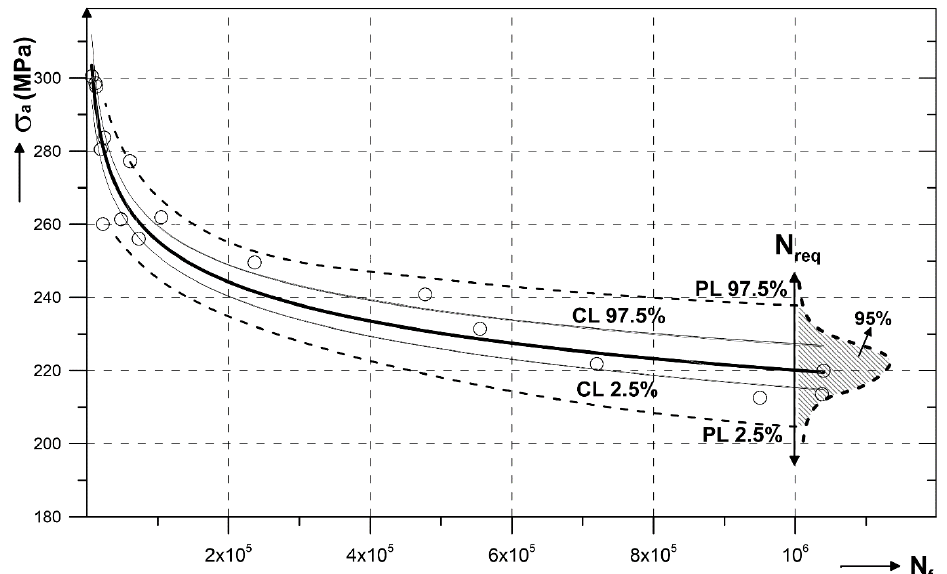
Figure 13. Scattering of cyclic material properties on the S–N material curve described using the intervals of reliability (confidence limit—CL, prediction limit—PL).